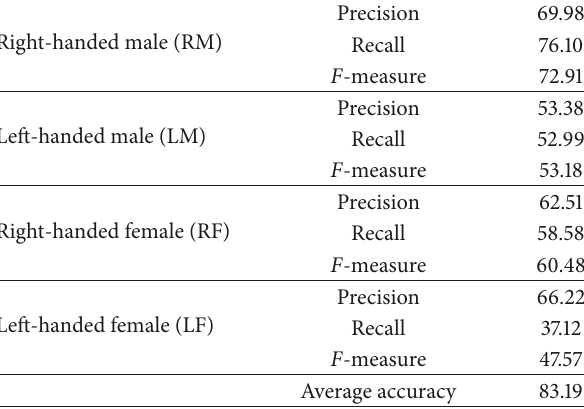
Table 3: Performance results for gender classification on IAM database.